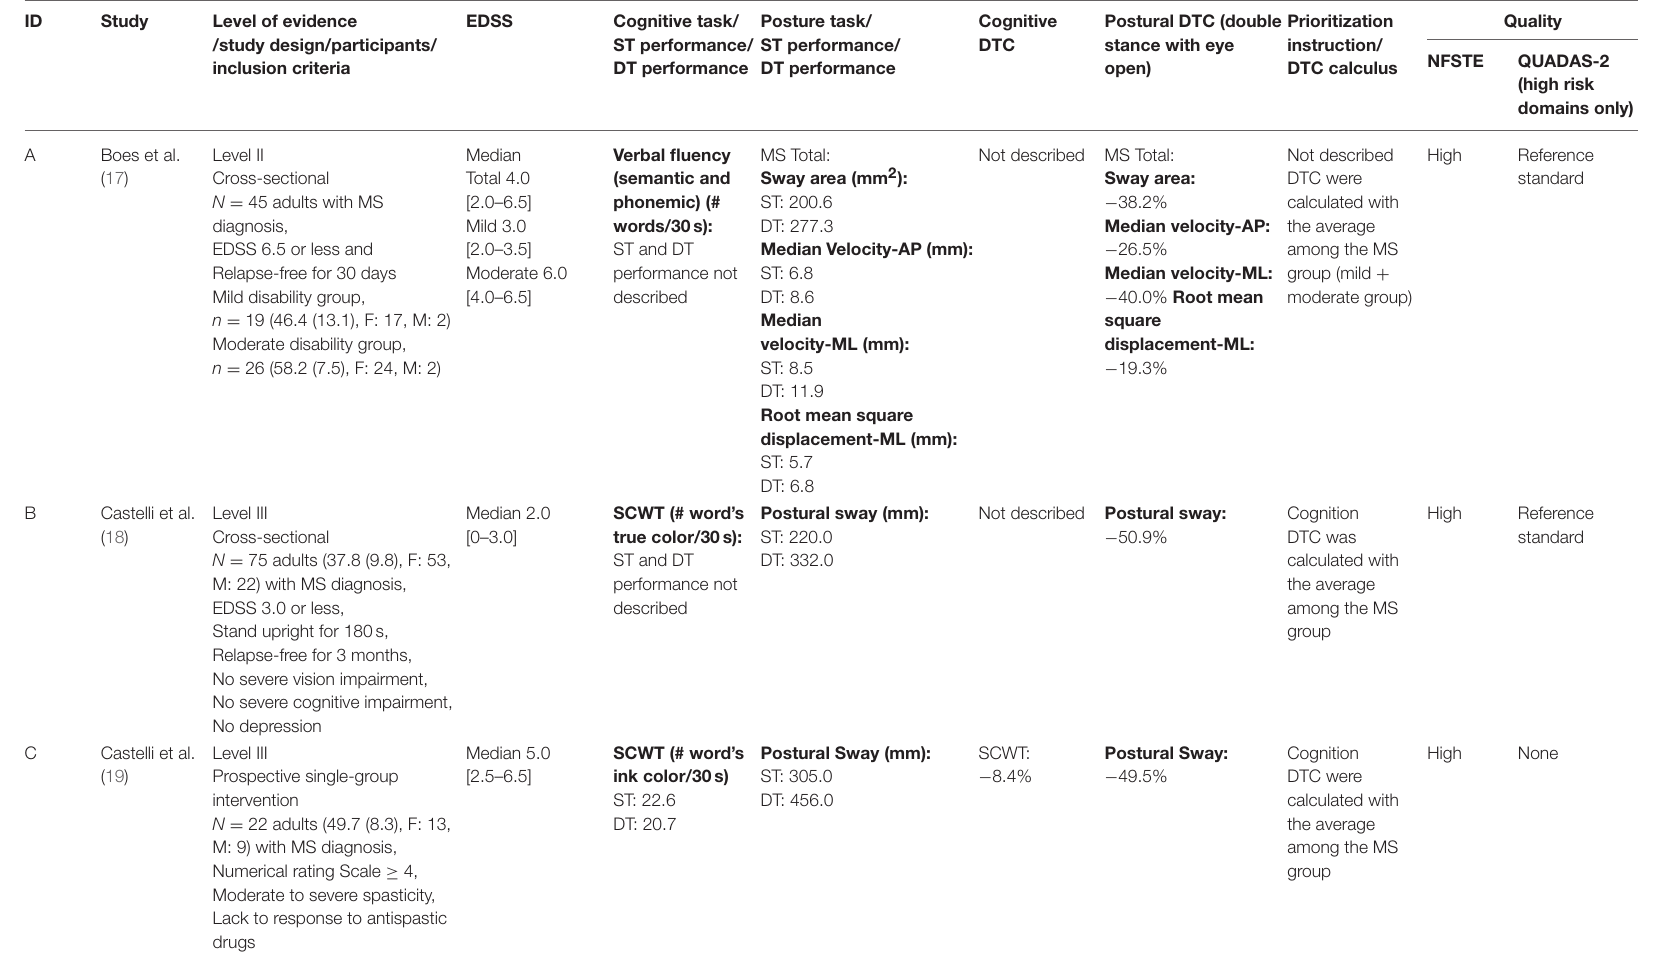
TABLE 1 | Summary of the characteristics of the studies included in the